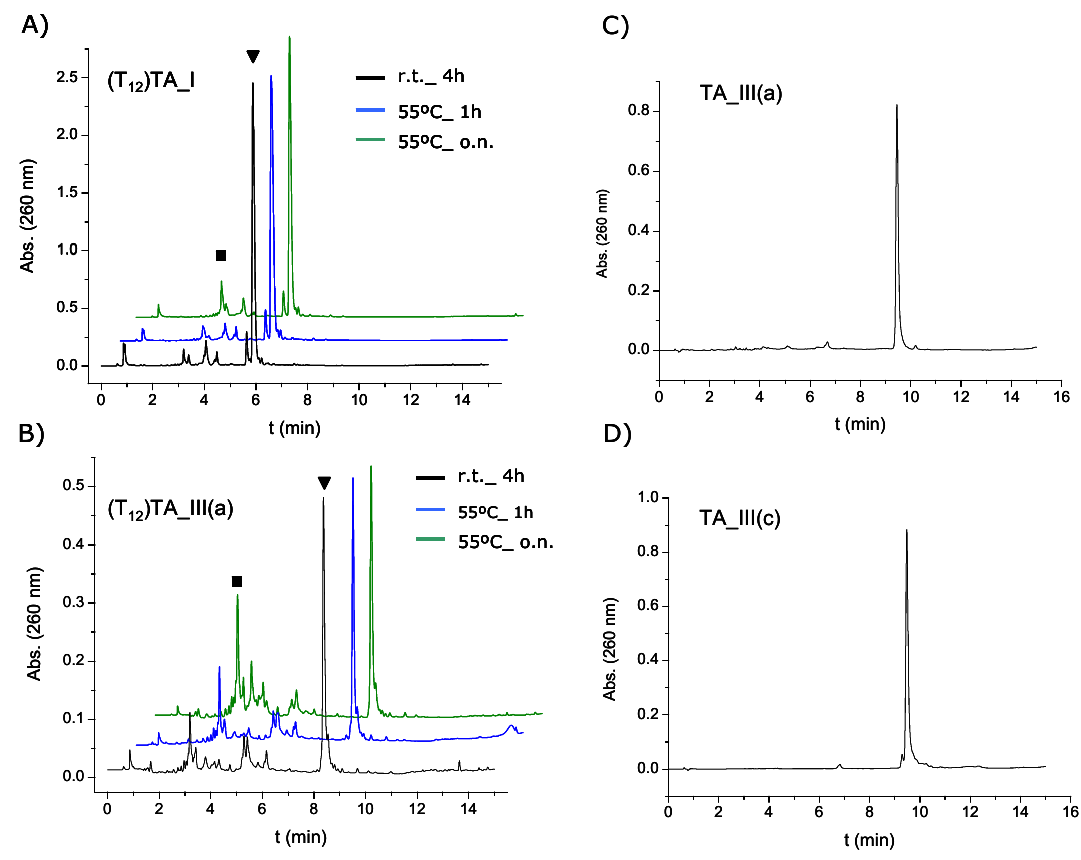
Figure 2. HPLC profiles of model oligonucleotides (XBridge OST C